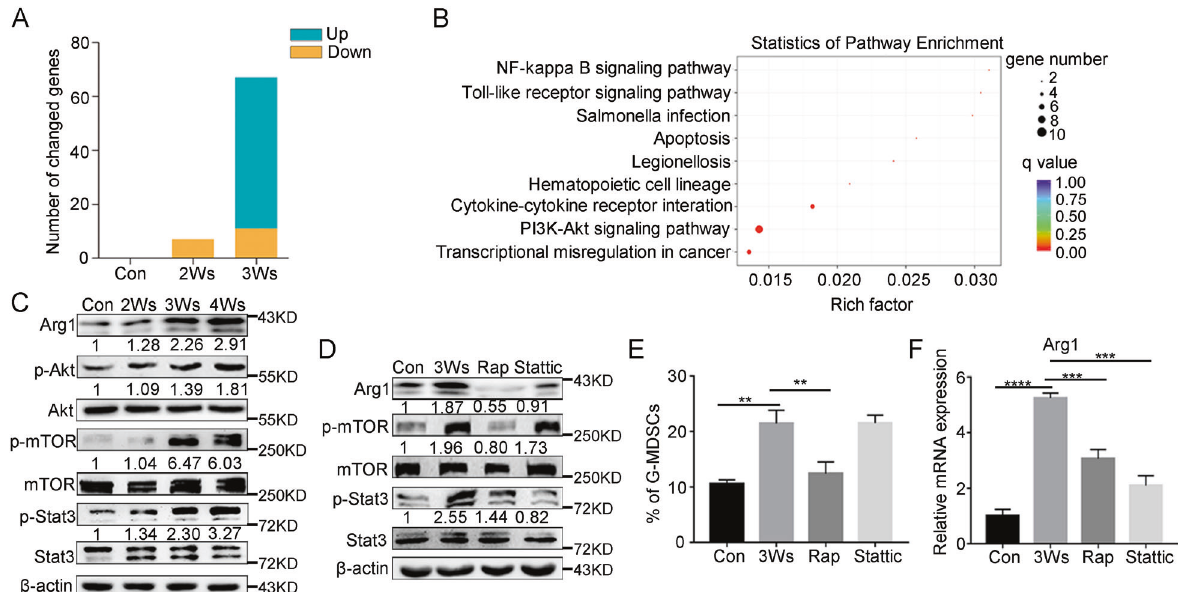
Fig. 3 Activation of the PI3K-Akt/mTOR pathway in G-MDSCs is related to the expression of immunosuppressive gene. A Number of genes that changed in G-MDSCs in peripheral blood taken from tumor-bearing mice compared to normal mice at different time points. B Kyoto Encyclopedia of Genes and Genomes (KEGG) pathway analysis of G-MDSCs in peripheral blood taken from mice bearing tumors for different durations based on differentially expressed genes. C The expression of Akt, p-Akt, mTOR, p-mTOR, Stat3, and p-Stat3 in G-MDSCs in peripheral blood taken from mice bearing tumors for different durations was analyzed by western blot. D The expression of mTOR, p-mTOR, Stat3, and p-Stat3 in G-MDSCs in peripheral blood taken from mice bearing tumors for 3 weeks was detected by western blot after injection of rapamycin (5 mg/kg) and stattic (4 mg/kg) into the tumor-bearing mice. E The proportion of G-MDSCs in peripheral blood was analyzed by FCM. The mice were treated as described in D ( n = 3). F The expression of Arg1 was detected by Q-PCR. The mice were treated as described in D ( n = 3). Results are mean ± SD. Unpaired t- test was used to determine signi fi cance (** p < 0.01, *** p < 0.001, and **** p <